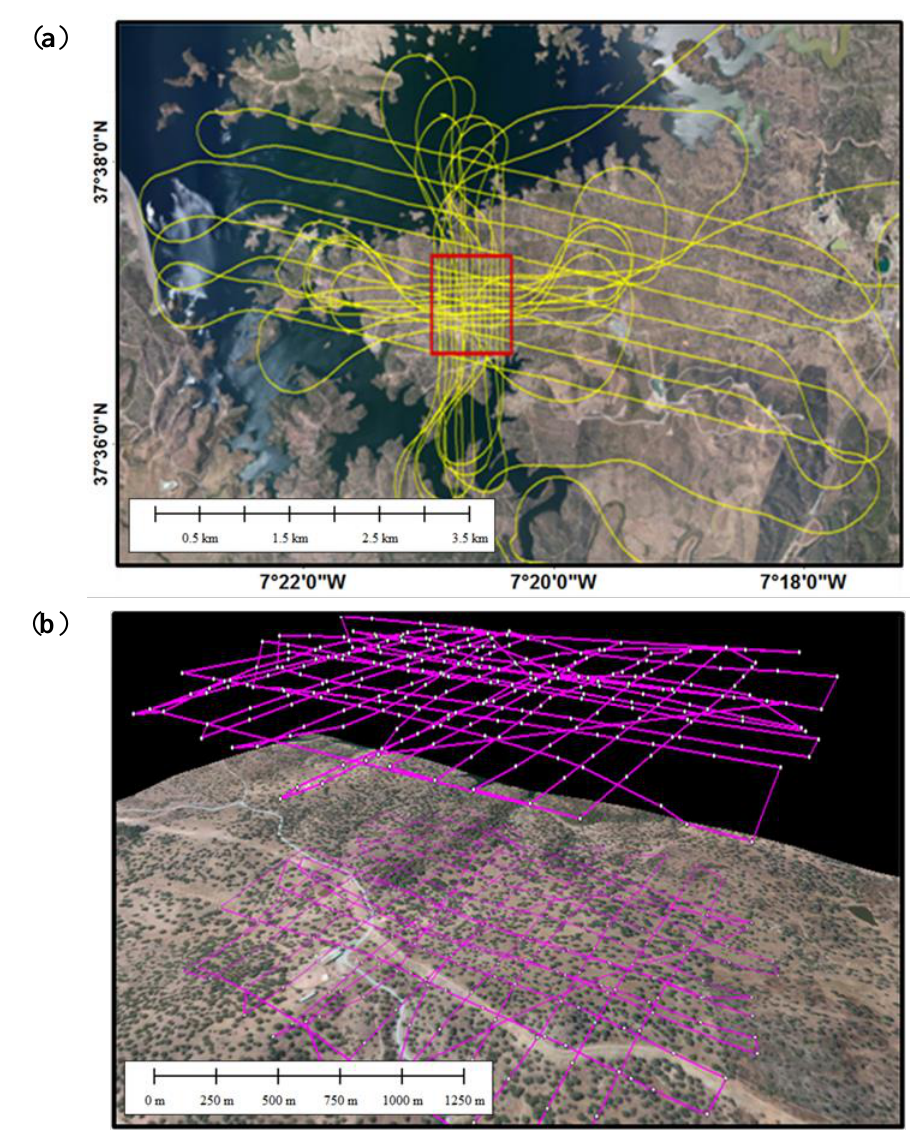
Figure 1. ( a ) Digital aerial image acquisition planning: spatial distribution of images acquired over the area. ( b ) Flight log showing the grid from east to